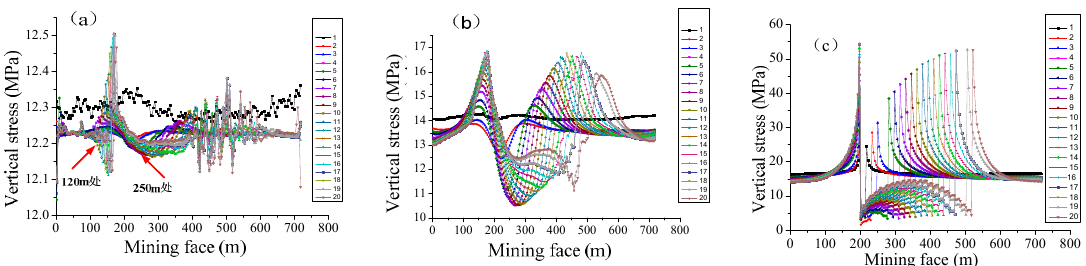
Figure 4. Stress response in the overburden. ( a ) Redistributed stress in the uranium deposit; ( b ) Redistributed stress in the conglomerate aquifer; ( c ) Redistributed stress in the coal seam.